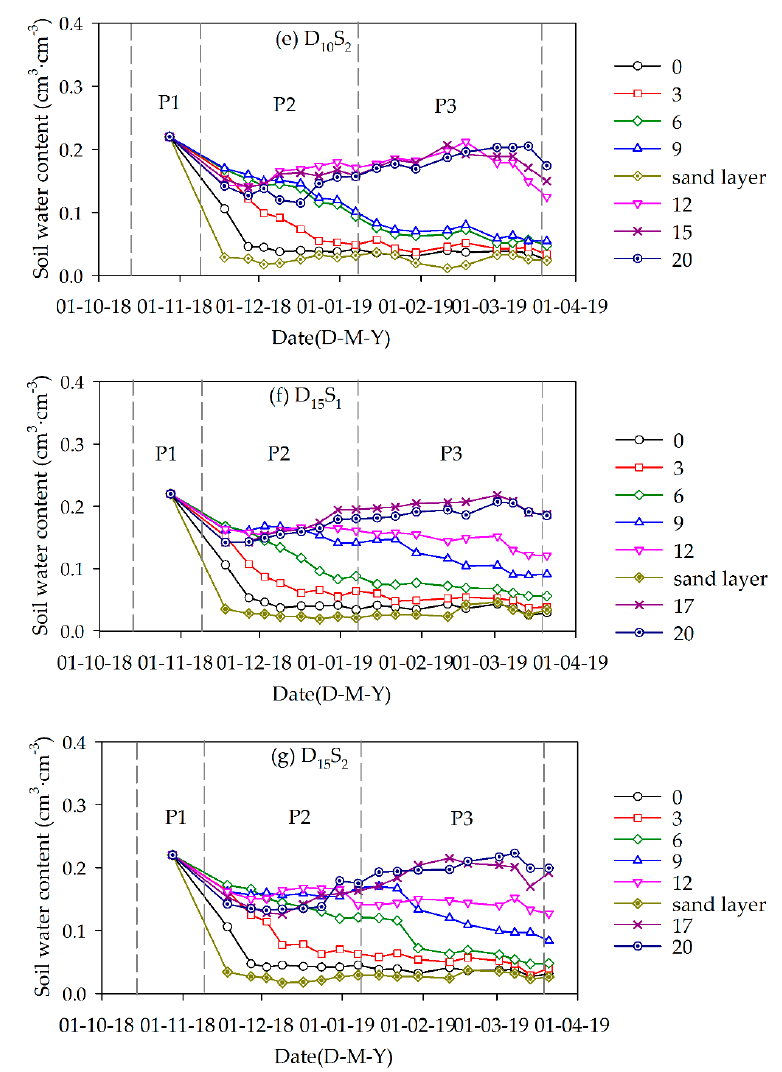
Figure 5. The soil water content at di ff erent depths in the ( a ) homogeneous soil column; ( b ) sand layer with a particle size between 0.5 and 1.5 mm and ( c ) between 2.0 and 2.5 mm embedded at the 5 cm depths; ( d ) sand layer with a particle size between 0.5 and 1.5 mm and ( e ) between 2.0 and 2.5 mm embedded at the 10 cm depths; ( f ) sand layer with a particle size between 0.5 and 1.5 mm and ( g ) between 2.0 and 2.5 mm embedded at the 15 cm depths during the seasonal freeze–thaw